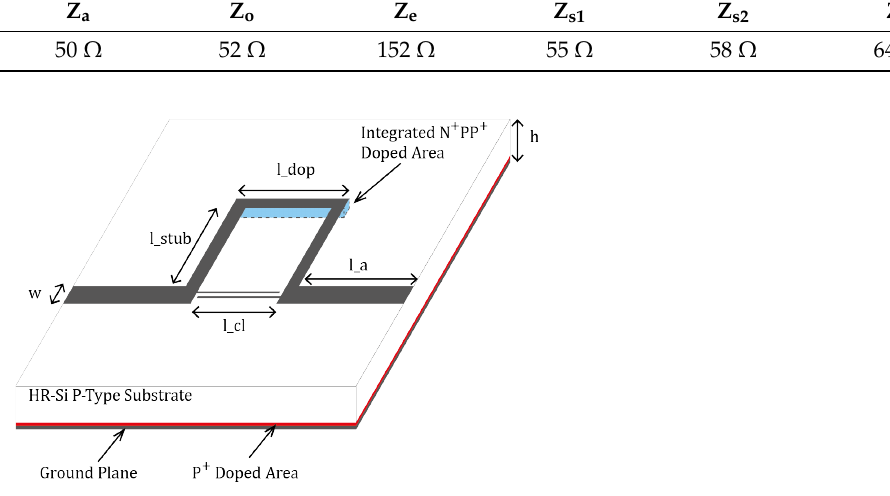
Figure 15. The 3D design of the 10 GHz reconfigurable filter.